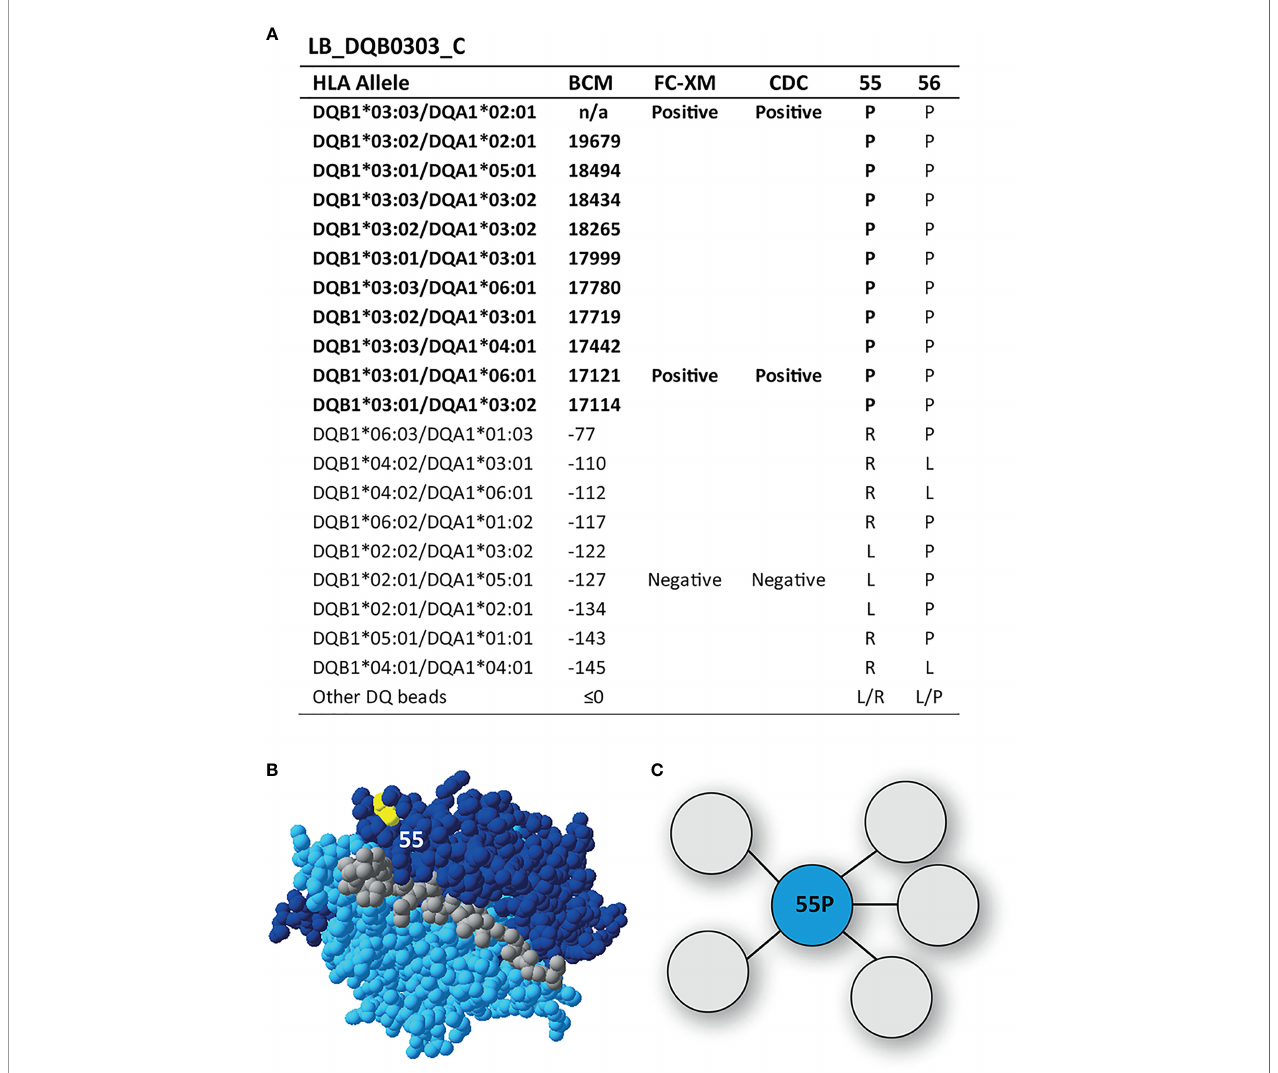
FIGURE 5 | Reactivity analysis of monoclonal antibody LB_DQB0303_C. (A) Comparison of the amino acid positions of interest of the HLA-DQB1 alleles on the reactive beads in the single antigen bead assay and a selection of the nonreactive HLA-DQB1 alleles. HLA-DQB1*03:03/DQA1*02:01 was not present in the single antigen bead panel. (B) Location of amino acid 55P (yellow) is indicated on the crystal structure of DQB1*03:02/DQA1*03:01 (PBD: 4Z7U). The b chain is depicted in dark blue, the a chain in light blue, and the peptide in grey. (C) Schematic representation of the antibody footprint of LB_DQB0303_C interacting with 55P as the functional epitope (cyan). BCM, background corrected mean fl uorescence intensity; FC-XM, fl owcytometric crossmatch; CDC, complement dependent cytotoxicity; PBD, Protein Data